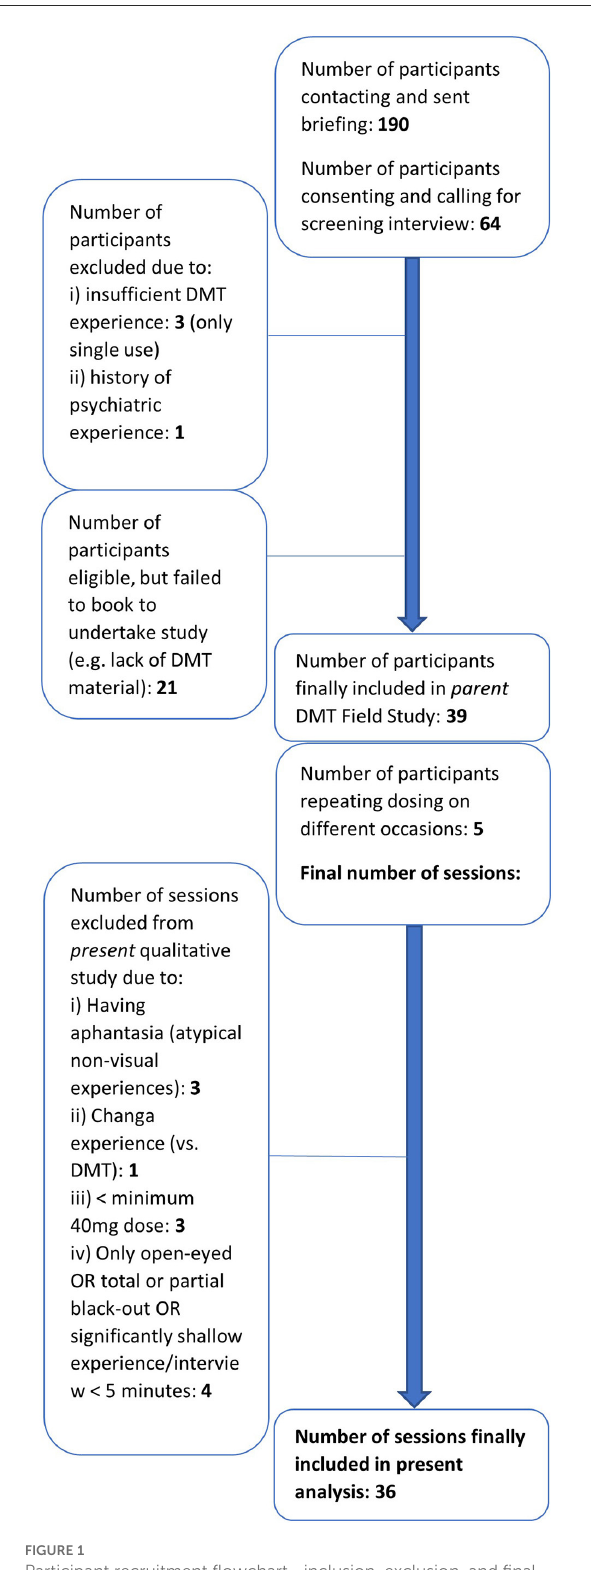
FIGURE1 Participant recruitment flowchart—inclusion, exclusion, and final sample size overall and of the present analysis.